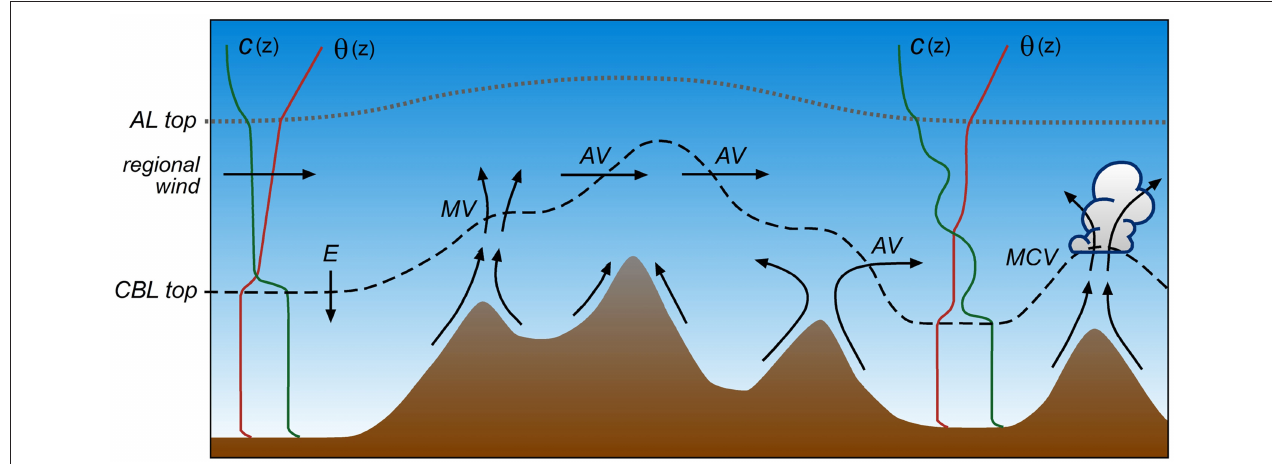
FIGURE 11 | Schematic illustration of mountain induced exchange processes between the convective boundary layer and the overlying atmosphere. E, entrainment; AV, advective venting; MV, mountain venting; and MCV, mountain-cloud venting. Vectors indicate airflow while c(z) and θ (z) indicate vertical profiles of pollutant concentration and potential temperature, respectively. The dotted and dashed line indicate the top of the aerosol layer (AL) and the CBL, respectively (after Kossmann et al., 1999; De Wekker, 2002; De Wekker et al., 2004).